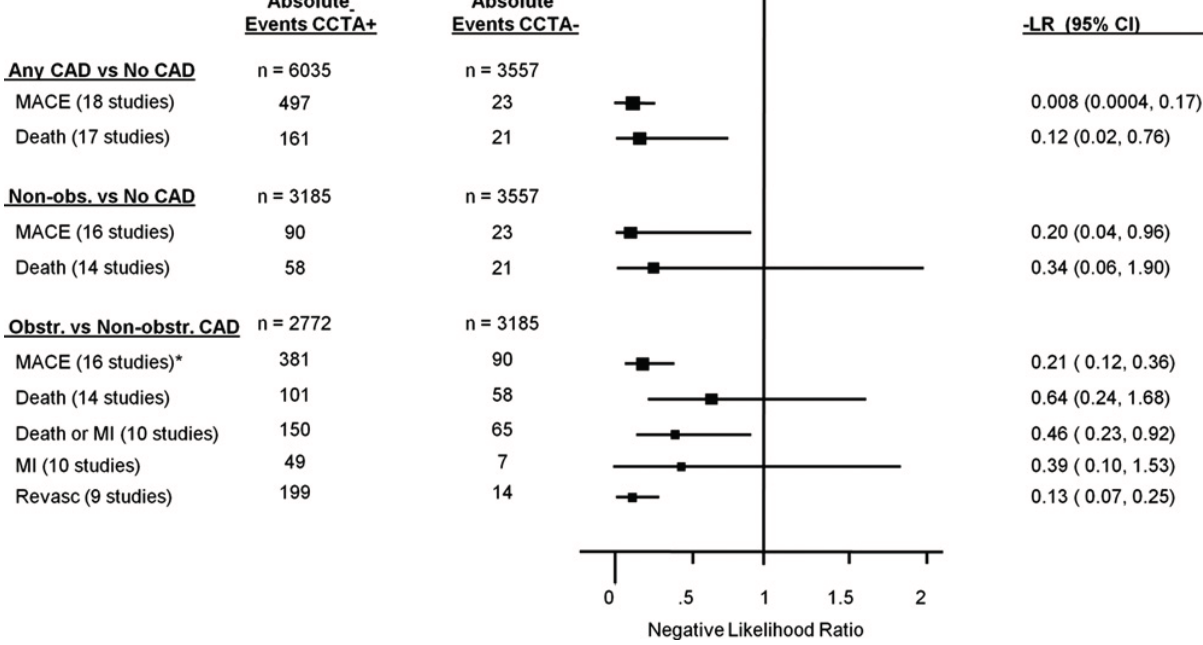
Figure 7. Pooled lifetime risk (LR) for major adverse cardiac events (MACE), death, death or myocardial infarctions (MI), MI and revascularization stratified by Coronary CT Angiography (CCTA) findings. Reproduced from [77] with permission from Hulten, J. Am. Coll. Cardiol. ; published by Elsevier,